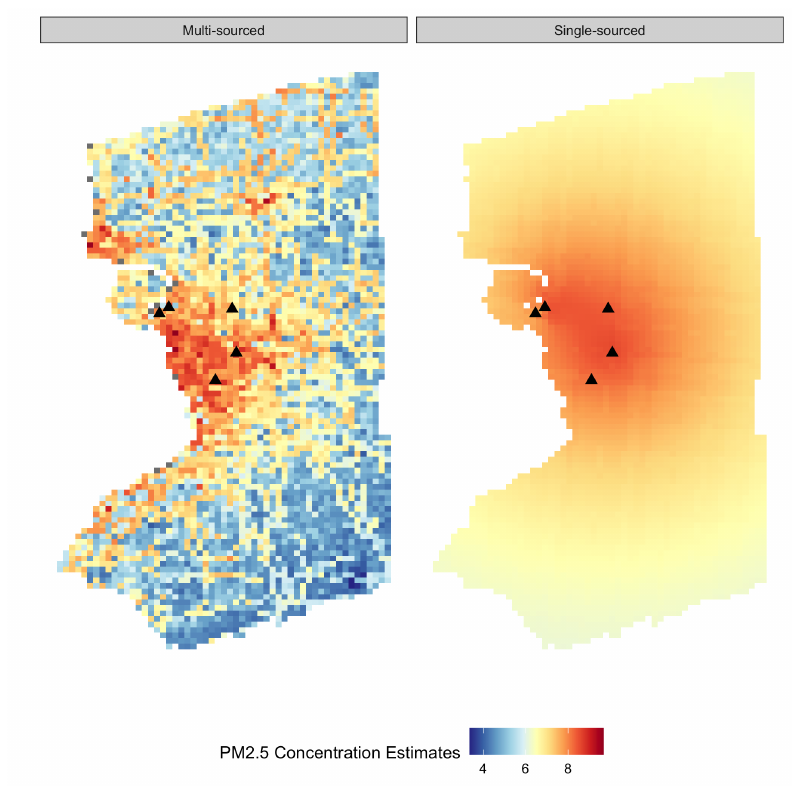
Figure 2. PM 2.5 estimates obtained from both a multi-sourced and single-sourced exposure models on 1 December 2016 overlaid with the five air monitoring stations operated in 2016 (denoted as symbols of black triangle).